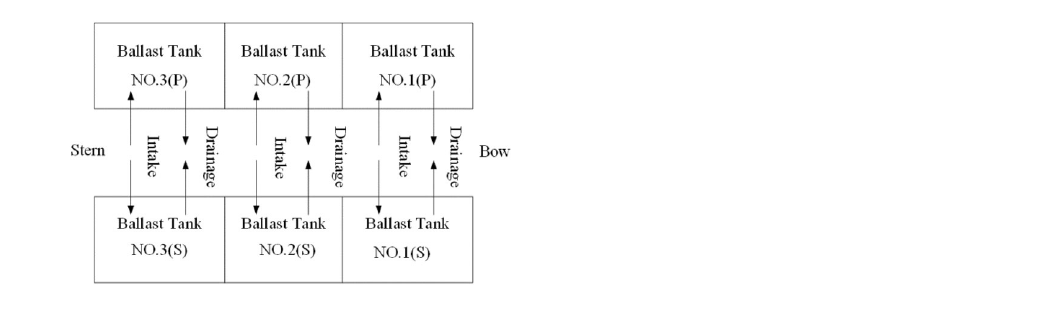
Figure 4. Ballast tank and ballast pump planning and